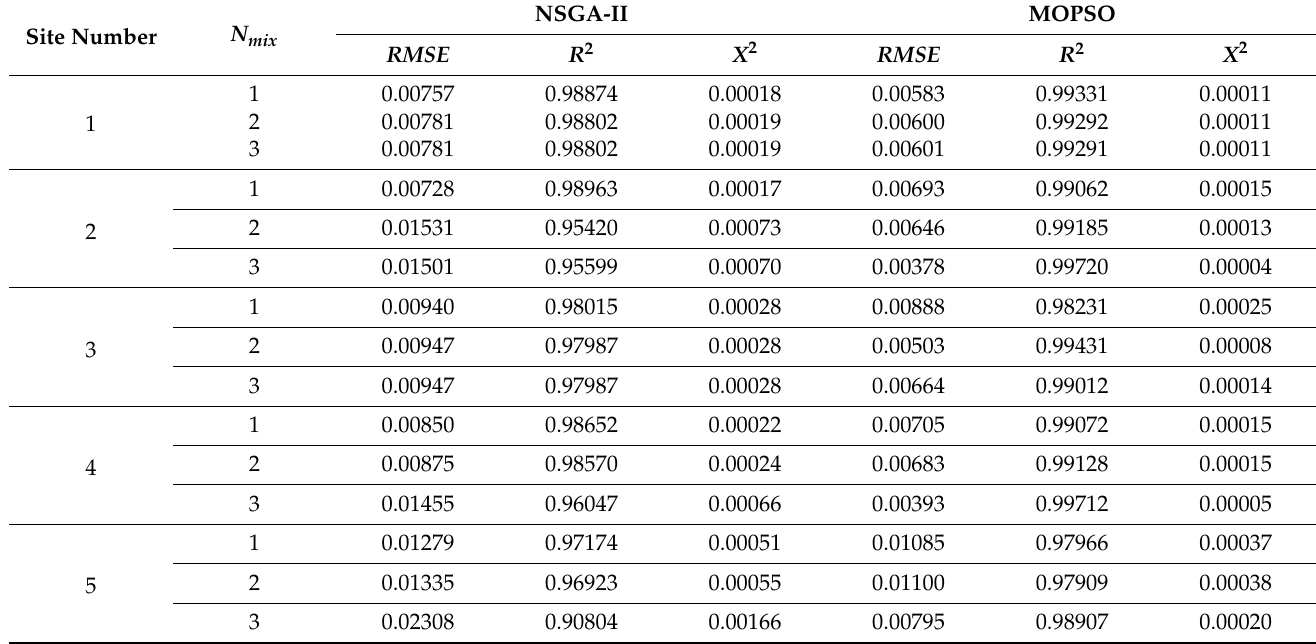
Table 4. Results obtained for 30 equal wind speed spacings in the five Egyptian